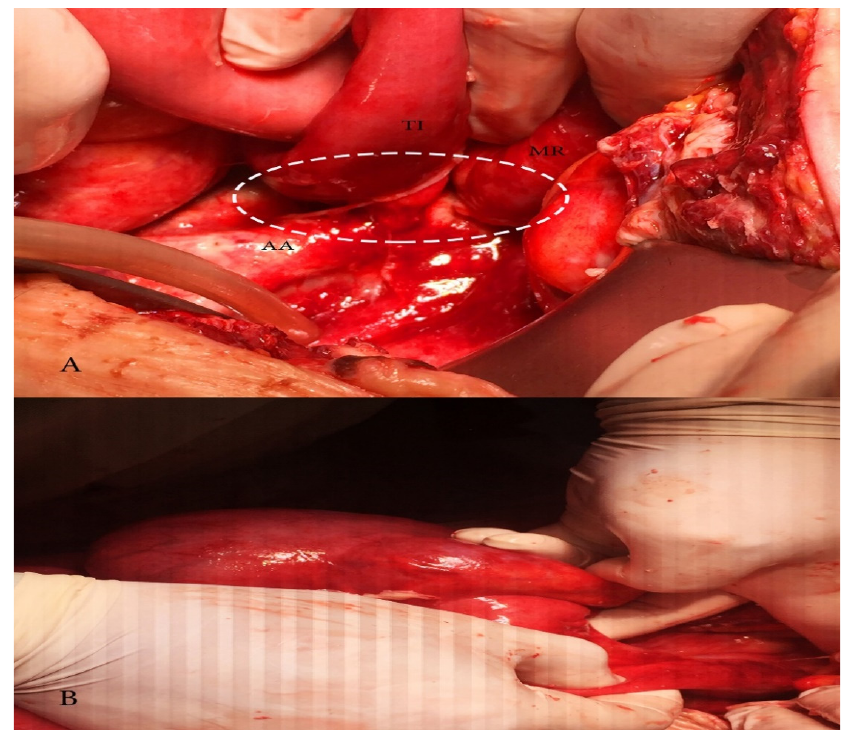
Figure 6. ( A ) Adhesion between terminal ileum and abdominal aorta causing obstructive ileus; MR— mesentery, TI—terminal ileum, AA—abdominal aorta; ( B ) dilatated